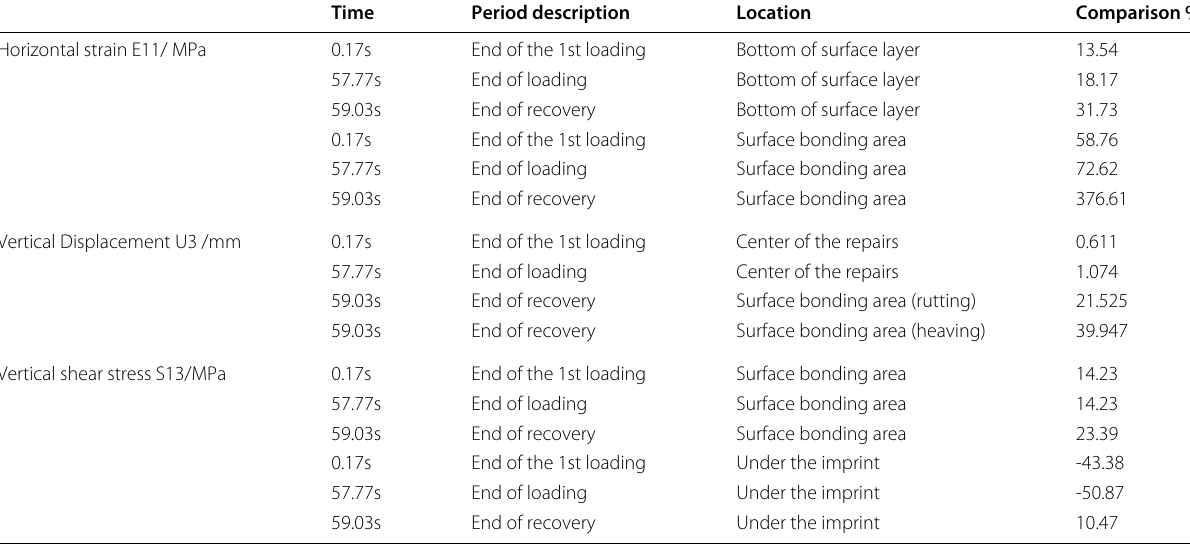
Table 4 Pavement effect of medium size repairs for circle and rectangle at different time and